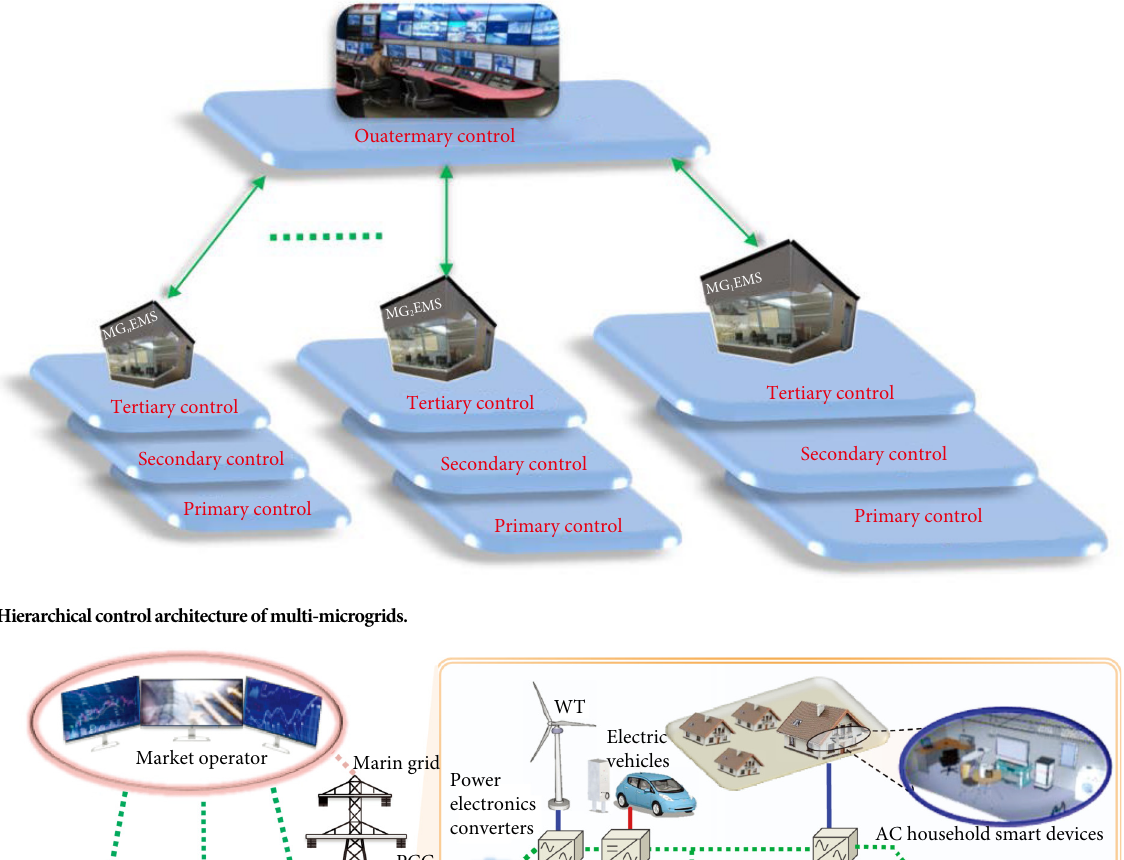
Fig. 4 Hierarchical control architecture of multi-microgrids.